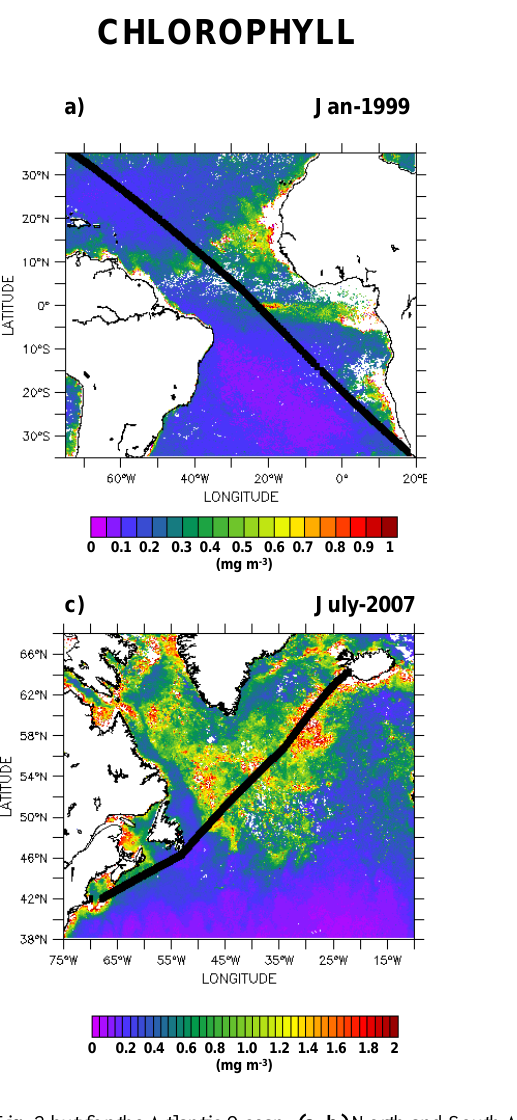
3.2 DMS:Chl and PHYSAT monthly PGD